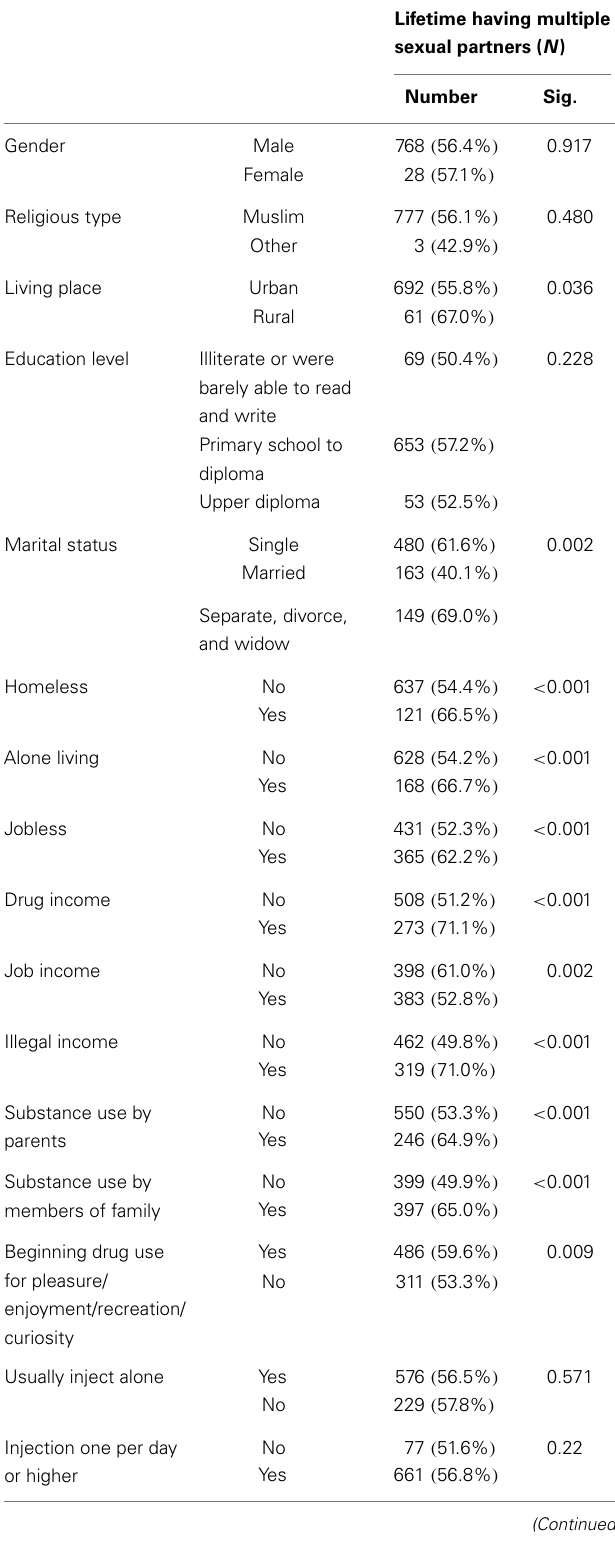
Table 1 |The comparison of lifetime extramarital sexual relation